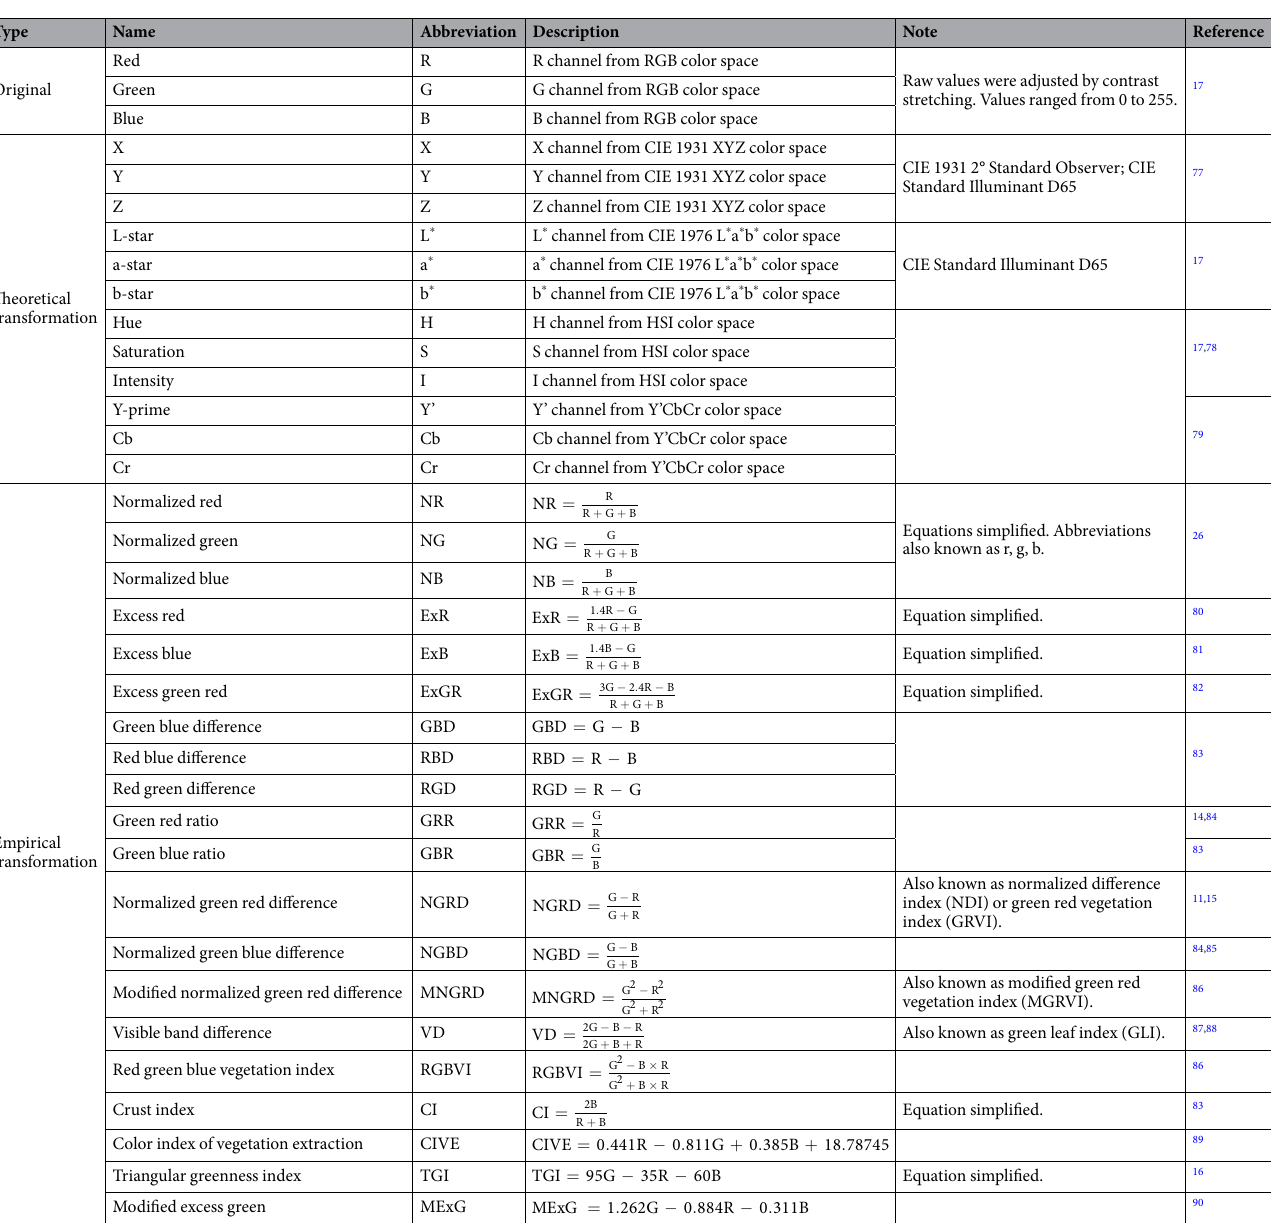
Table 4. List of theoretical and empirical RGB image